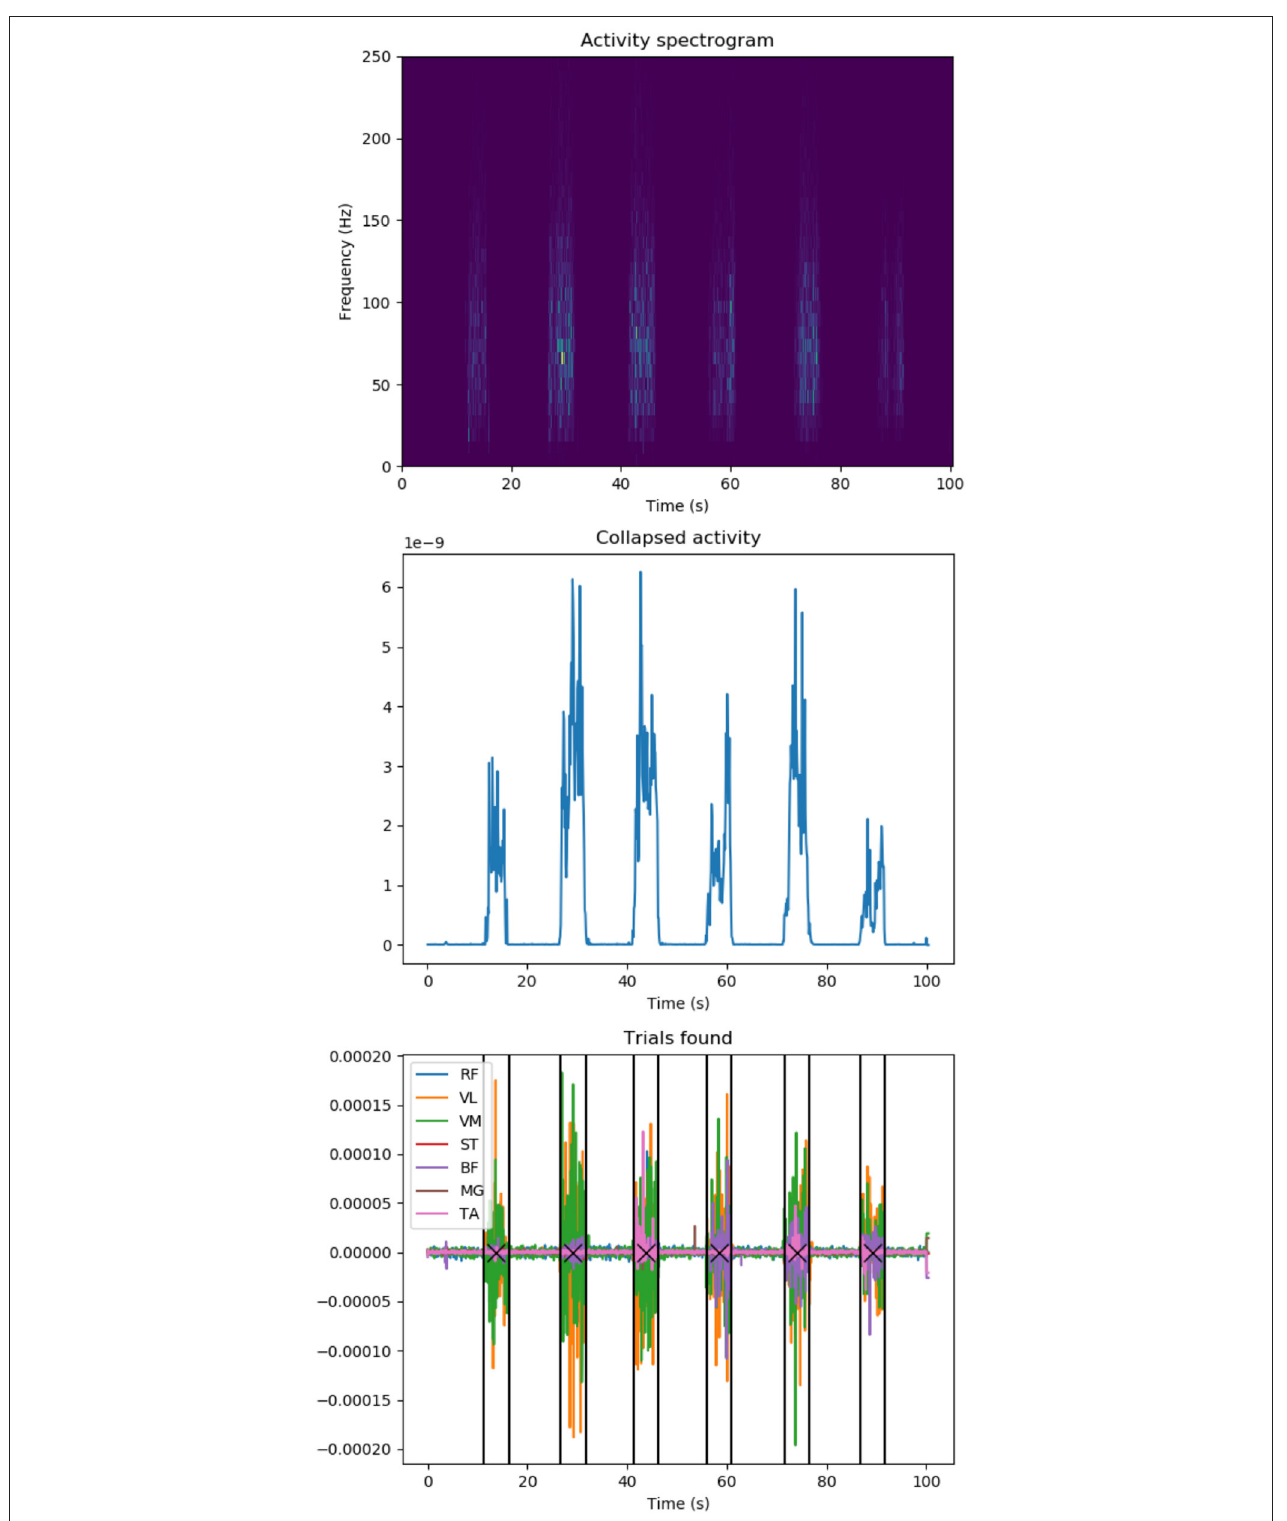
FIGURE 4 | EMG data knee extension trial localization: (top) Activity spectrogram of all muscle recordings: Frequency spectograms for all recorded muscles are added up to identify overall muscle activation during a participant trial session. (Middle) Summed activity spectrogram: Frequencies are added up at any given time point to spot knee extension trial durations. (Bottom) Identified knee extension trials in original recorded EMG data (colors represent individual muscles): a participant executes several trials of knee extension in a row, we apply signal processing to identify trial duration (vertical lines) and centers (crosses). Y-axes values are in arbitrary units unless